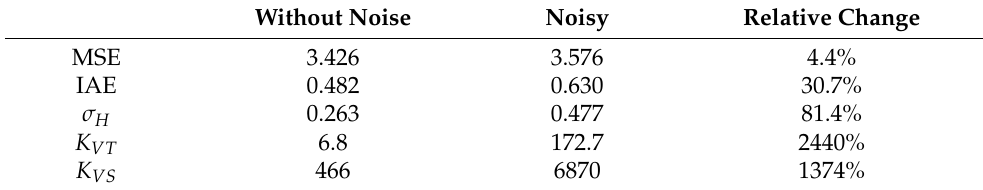
Table 8. G 4 ( s ) CPA indexes.